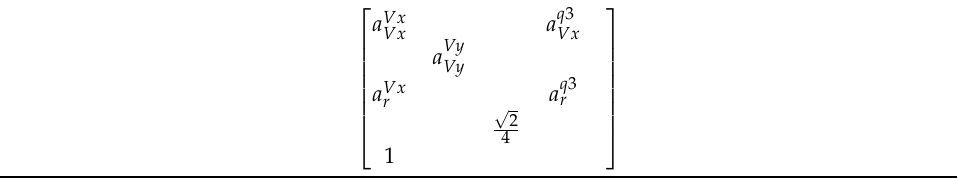
Table 3. Stability matrix for longitudinal motion in ascending/descending evolution A .